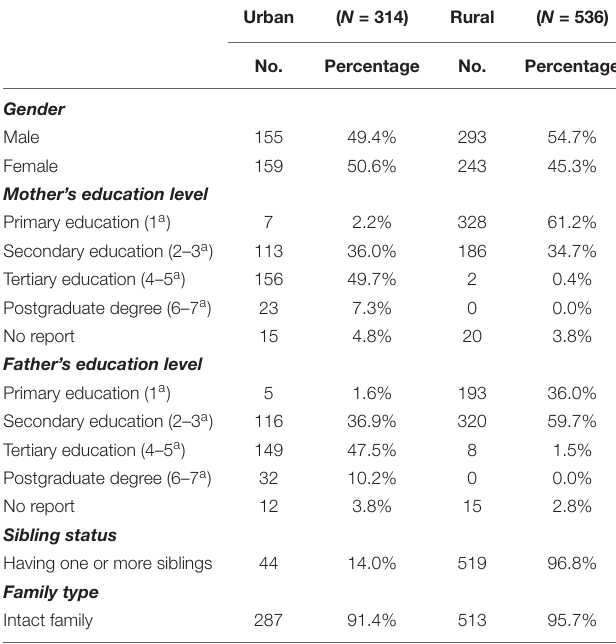
TABLE 1 | Demographic characteristics of the